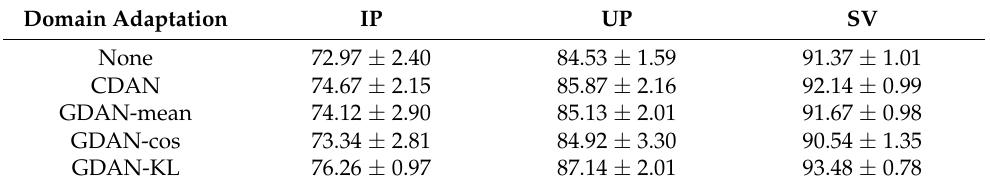
Table 5. OAs obtained by GDAFSL with various domain adaptation methods on three HSI datasets. Domain Adaptation